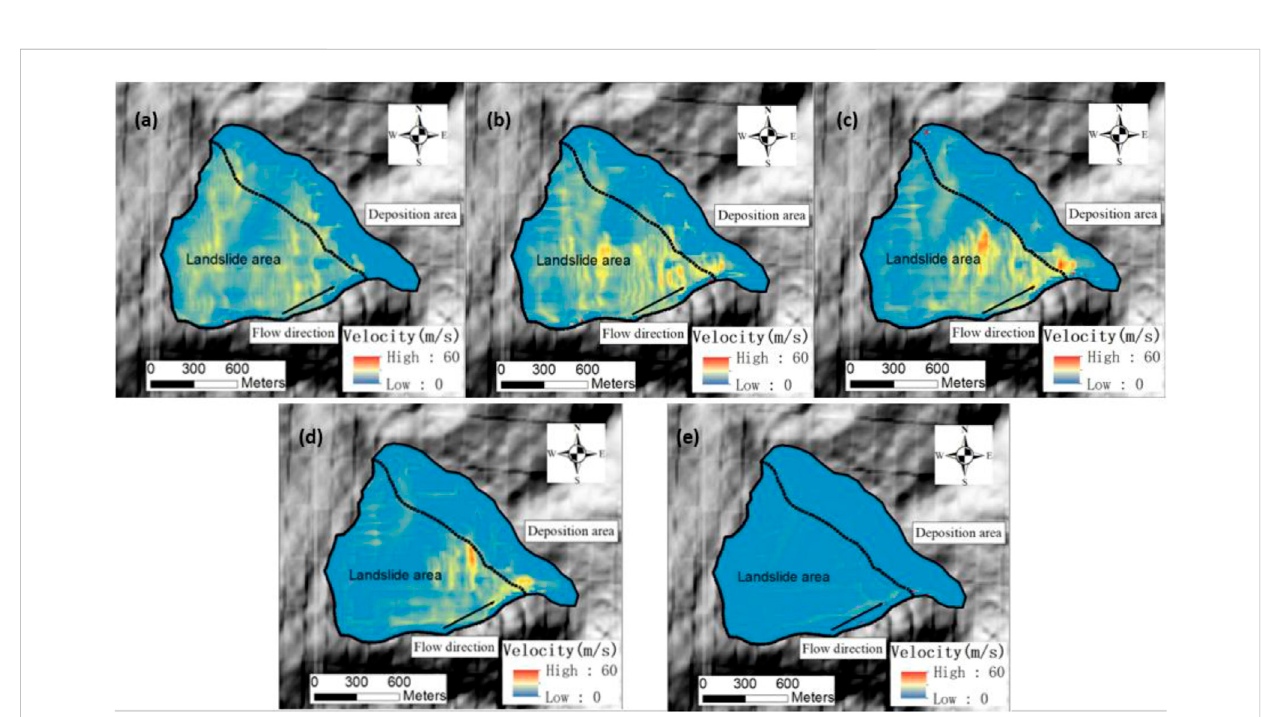
Velocity of the landslide movement: (A) t = 20 s, (B) t = 40 s, (C) t = 60 s, (D) t = 80 s, and (E) t = 100